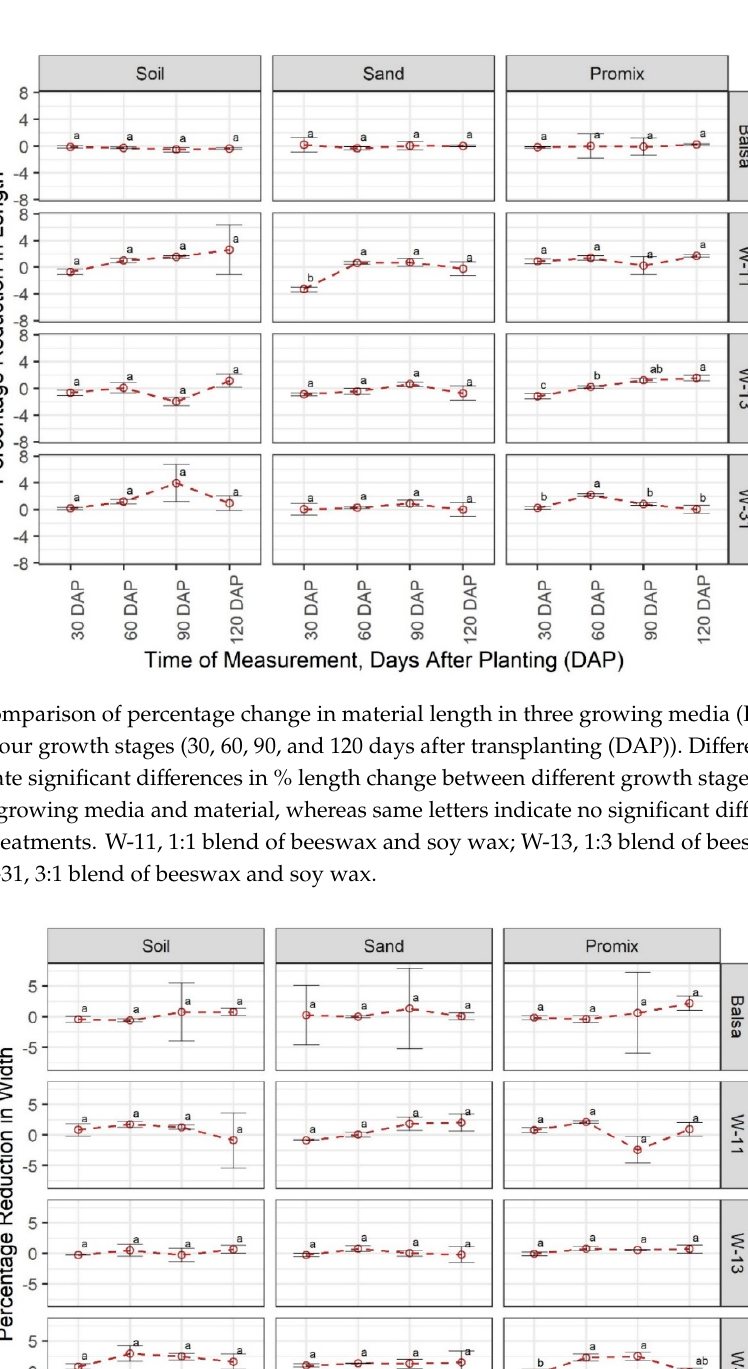
Figure 1. Comparison of the percentage change in material weight in three growing media (Promix, sand, and soil) at four growth stages (30, 60, 90, and 120 days after transplanting (DAP)). Different lowercase letters indicate significant differences in % weight change between different growth stages, at α = 0.05, within each growing media and material, whereas the same letters indicate no significant difference across compared treatments. W-11, 1:1 blend of beeswax and soy wax; W-13, 1:3 blend of beeswax and soy wax; and W-31, 3:1 blend of beeswax and soy wax.